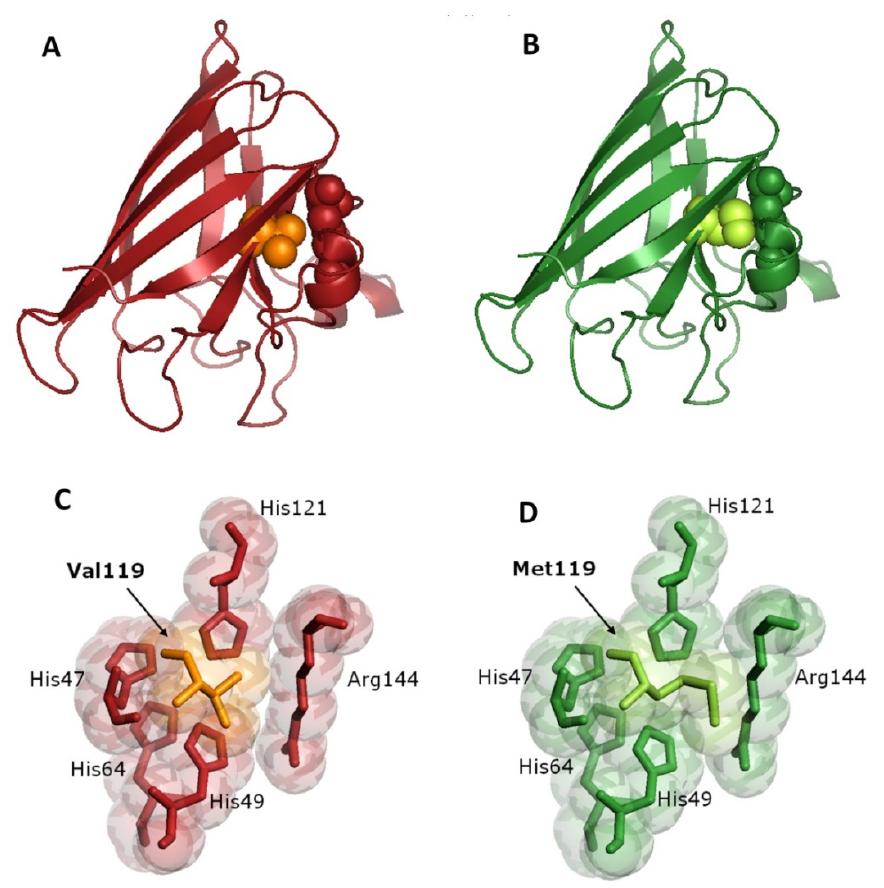
Figure 3. ( A ) Three-dimensional x-ray diffraction structure of wild type human SOD1 protein (PDB2c9vA); ( B ) Model of the SOD1 p.V119M mutation: spheres of the same color of the protein chain represent arginine 144, valine and methionine at position 119 are represented by orange/light green spheres, respectively; ( C ) Stereo image showing the amino acids constituting the copper binding site of wild type SOD1 protein (His47, His49, His64, His121 and Arg144) and Val119; ( D ) Stereo image showing the amino acids constituting the copper binding site of mutated p.V119M SOD1 protein (His47, His49, His64, His121 and Arg144) and the increased steric hindrance of Met119.